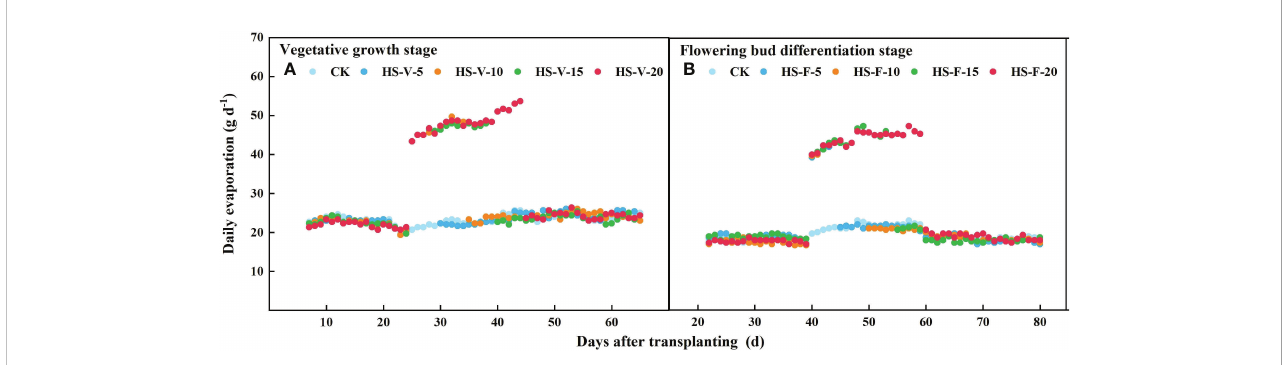
FIGURE 9 Variation of daily evaporation (A, B) exposed to different temperature treatments during the vegetative growth (A) and fl owering bud differentiation stages (B)